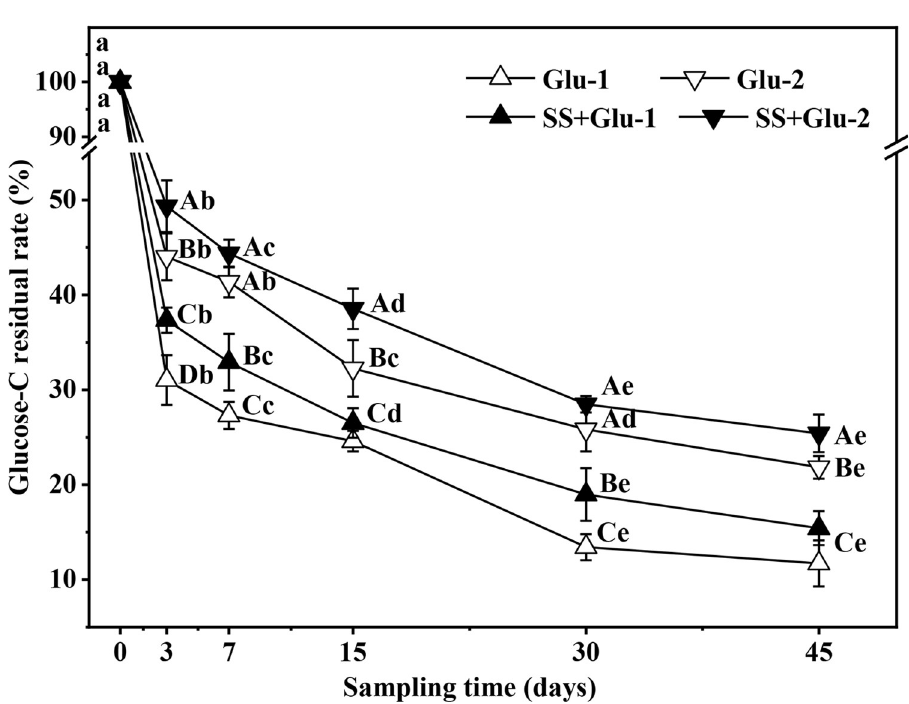
Fig 1. Change in glucose C residual rate with sampling time in the sterilized and non-sterilized soils with glucose addition. Different uppercase letters indicate significant differences ( P < 0.05) among different treatments at the same sampling time. Different lowercase letters indicate significant differences ( P < 0.05) among different sampling time within the same treatment. Overlapping date points with the same significant differences are indicated by common letters. CK, non-sterilized soil without glucose addition; Glu-1, non-sterilized soil with low level of glucose addition; Glu-2, non-sterilized soil with high level of glucose addition; SS, sterilized soil without glucose addition; SS+Glu-1, sterilized soil with low level of glucose; SS+Glu-2, sterilized soil sterilization with high level of glucose addition.